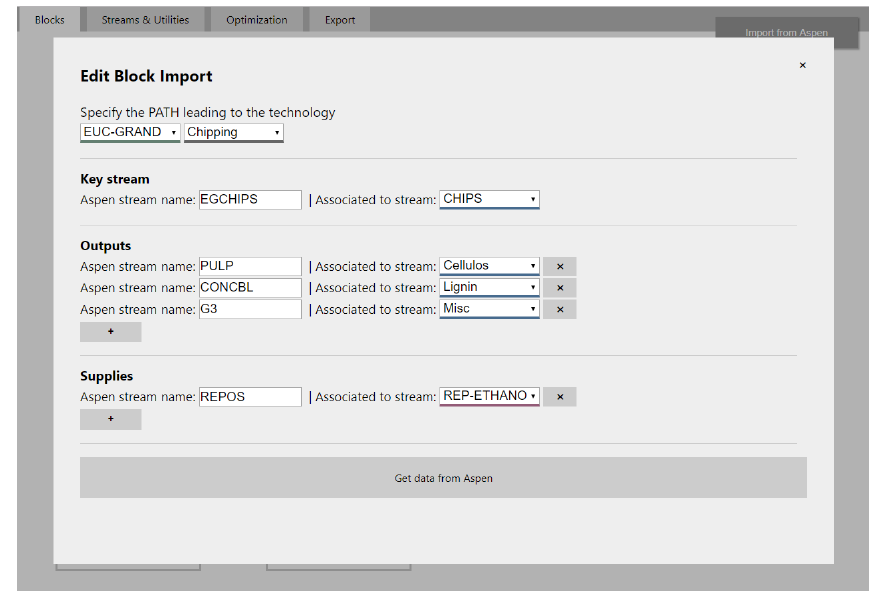
Figure 7. Screenshot of the data request screen for accessing Aspen Plus .bkp information. The request screen was thought to be used in conjunction with an Aspen Plus Collaborative Environment proposed in previous works (see the work by the authors of [8]). Aspen Stream name corresponds to the name given to the stream in the Collaborative Environment (see Section S1.1 in Supplementary